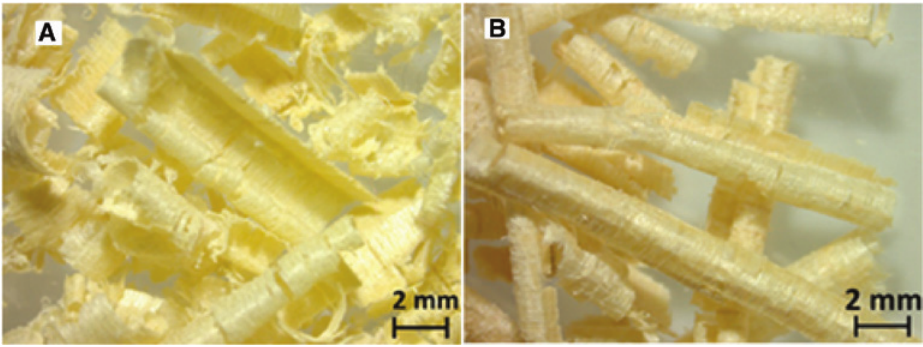
Figure 1: Wood shavings used in the study: (A) Ayous, (B)